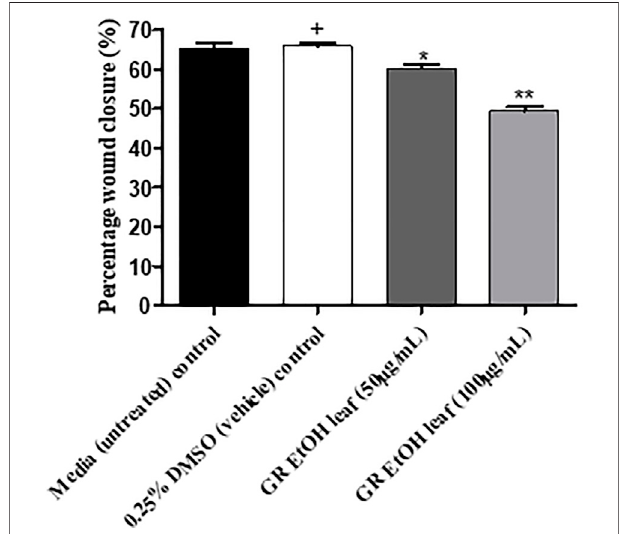
FIGURE 5 | Percentage wound closure (%) of G. radlkoferi EtOH leaf extract (50 and 100 μ g/ml) on HaCat cells after 18 h incubation. Values are displayedasmean±standarddeviation( n =2),where* p < 0.05and** p < 0.01 indicated statistical signi fi cance (one-way ANOVA and Dunnett ’ s multiple comparison test) when compared to the 0.25% DMSO (vehicle) control (+). No statistical difference was determined between the media (untreated) control and the 0.25% DMSO (vehicle)